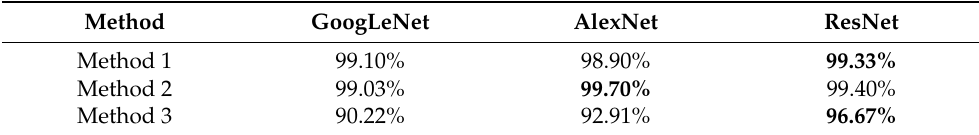
Table 4. Correctness rate for different input